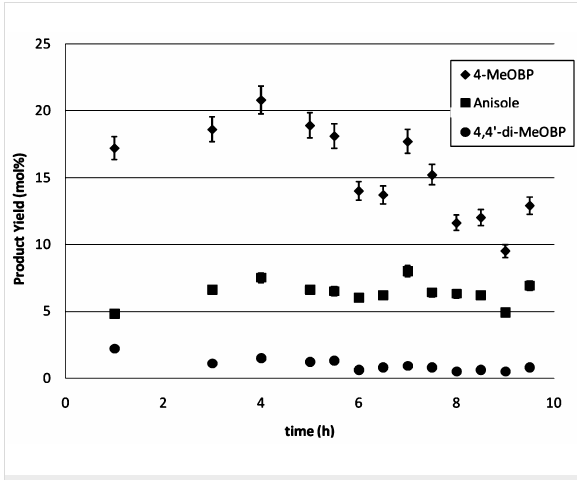
Figure 7: Kumada reaction carried out in a parallel channel meso reactor at a flow rate of 190 ml h −1